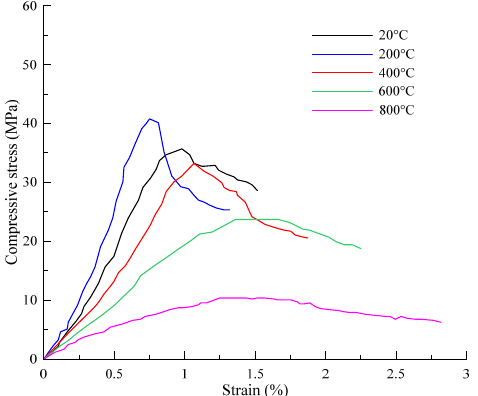
Figure 1. Compressive stress–strain curves of specimens after exposure to high temperatures for different heating durations [25].